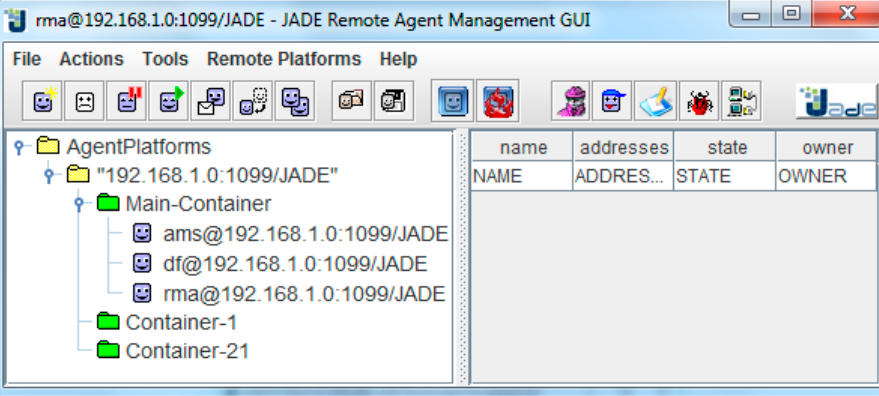
Figure 6. The GUI of the Main Container.